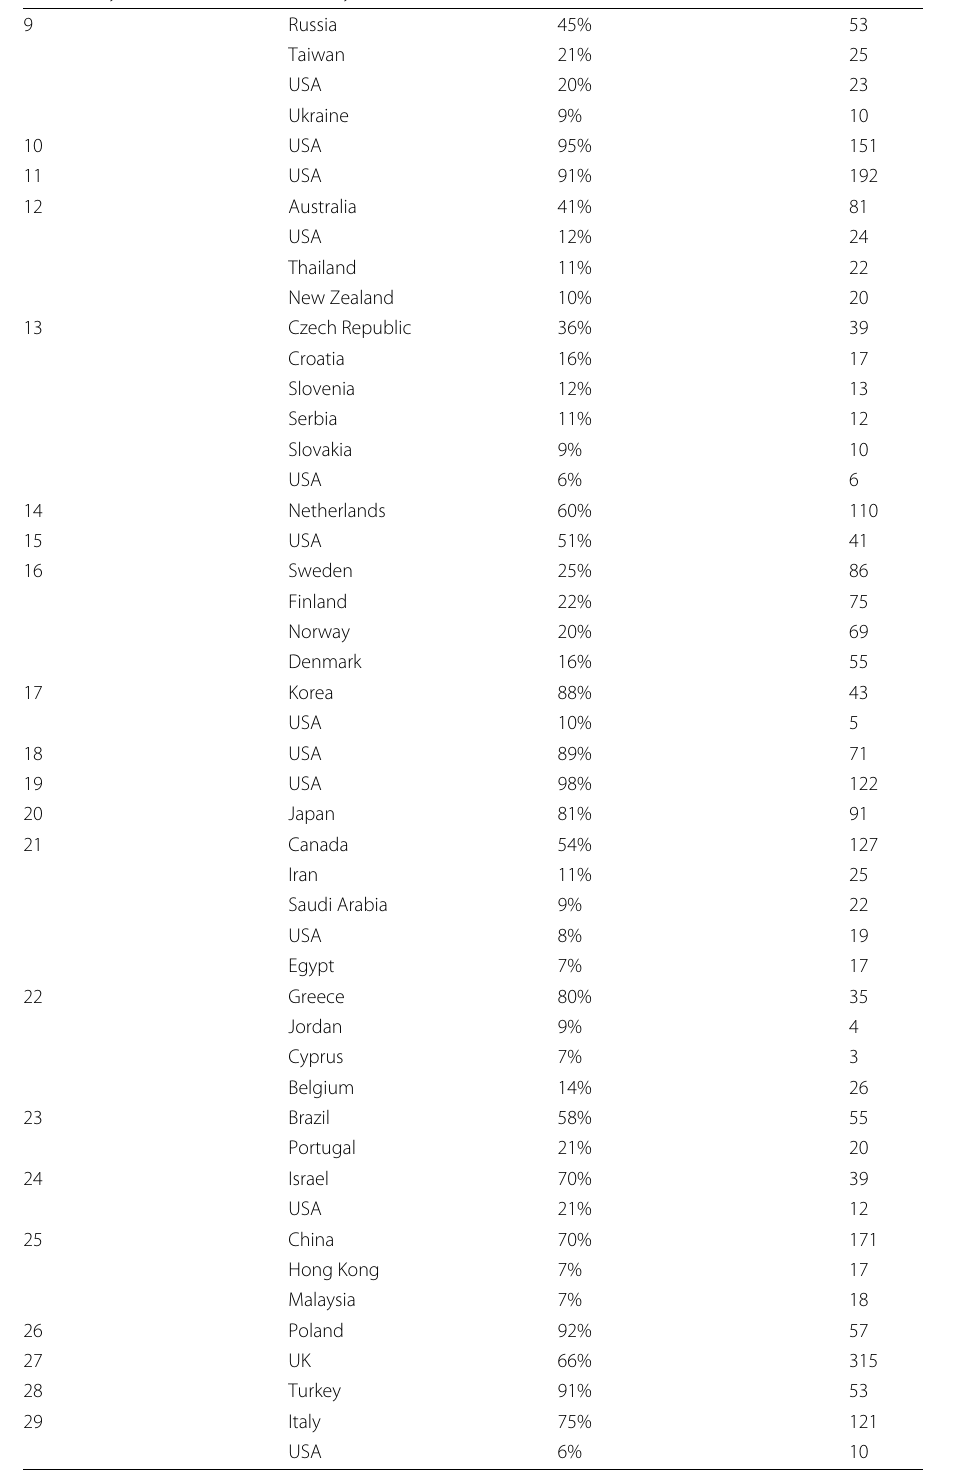
Table 4 Breakdown of communities by country. For each modularity class the number of cities belonging to a country are listed along with their proportion of cities in the class. For example community 15 is composed of 25% Swedish, 22% Finnish, 20% Norwegian and 16% Danish cities as well as 17% smaller cities. Note: only countries with at least 5% member cities are listed ( Continued ) Community ( x ) Country ( c